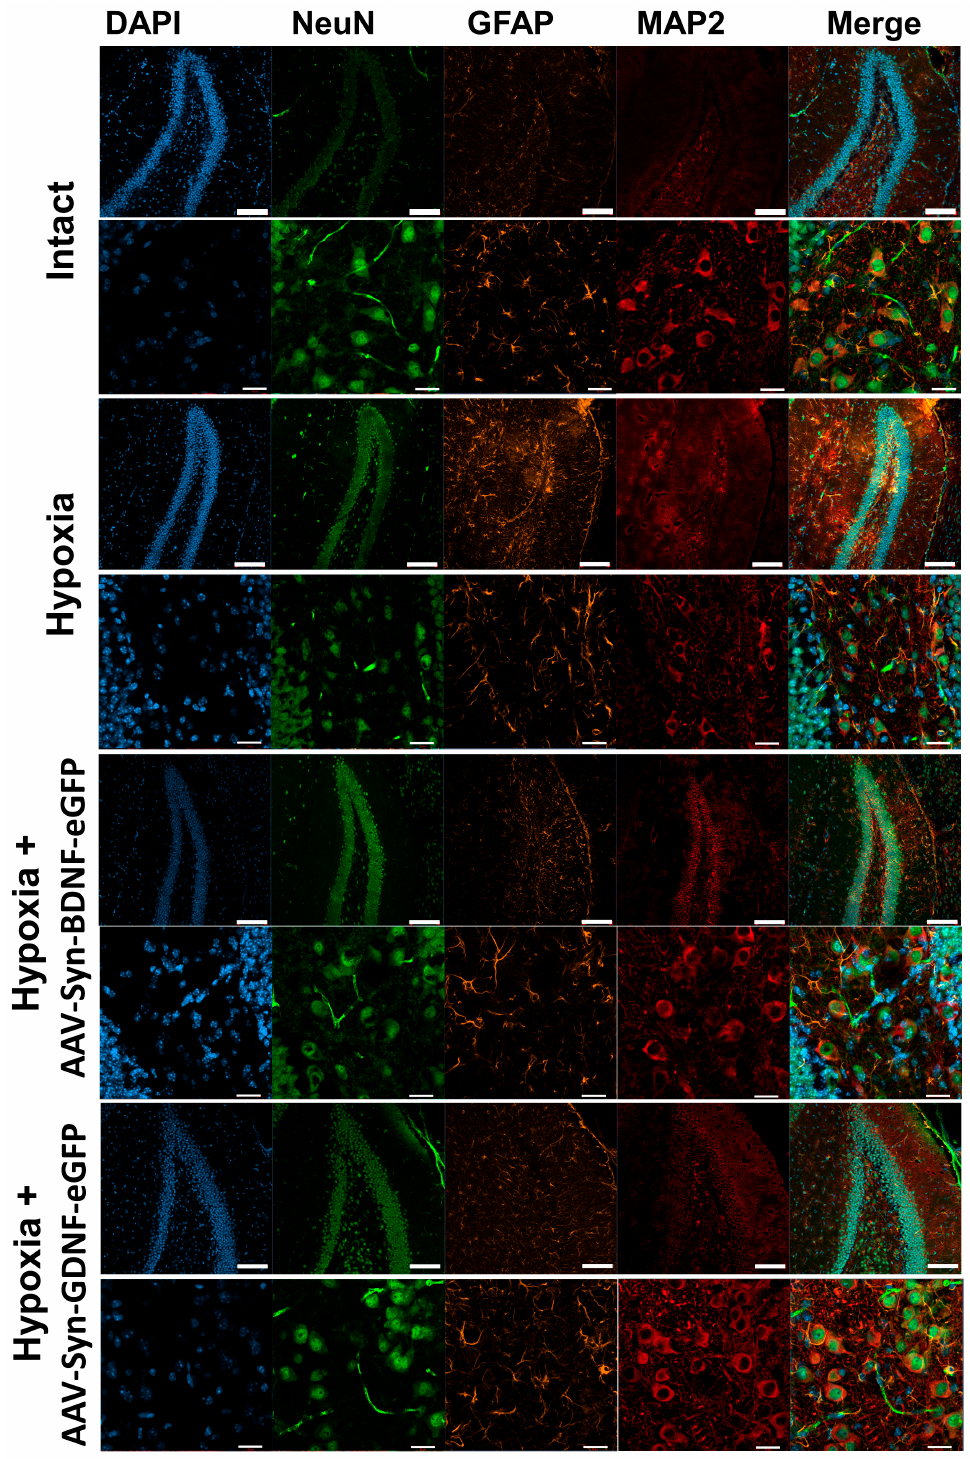
Figure 6. Representative confocal images of ICC of mouse brain slices on day 7 after acute hypobaric hypoxia modelling: “Intact”, “Hypoxia”, “Hypoxia + AAV-Syn-BDNF-eGFP”,”Hypoxia + AAV-Syn- GDNF-eGFP”. Blue—DAPI, Green—NeuN, Orange—GFAP, Red—MAP2. Odd rows-scale bar–100 µ m (Plan-Apochromat 10 × /0.3 objective). Even rows -scale bar–20 µ m Plan-NeoFluar 40 × /0.75 objective. A laser scanning microscope LSM 800 (Zeiss, Oberkochen, Germany) was used for the